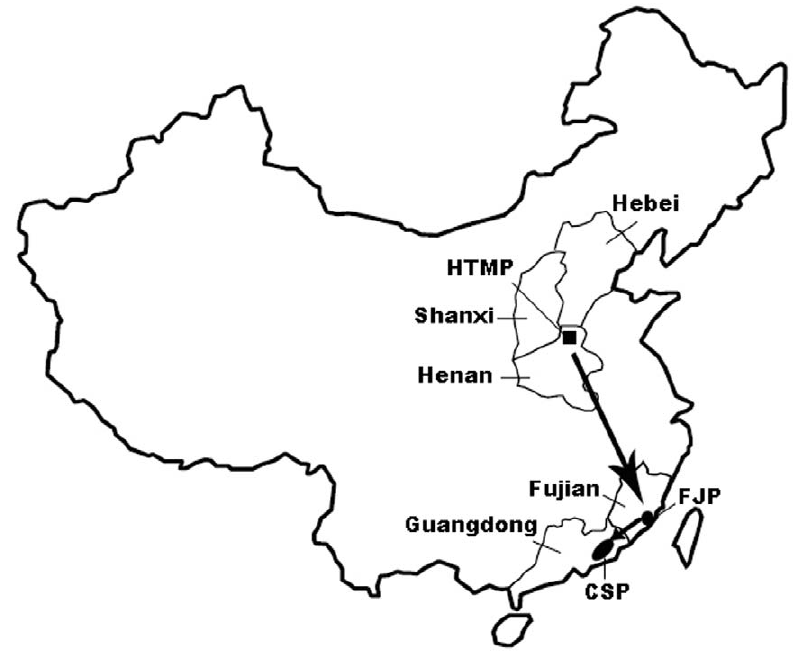
Figure 1. Geographic distribution of the three studied EC high-risk populations. Arrows show the north-to-south migrations of Han inhabitants from north-central China according to historical records. CSP, Chaoshan EC high-risk population; FJP, Fujian EC high-risk population; HTMP, Henan Taihang Mountain EC high-risk population.